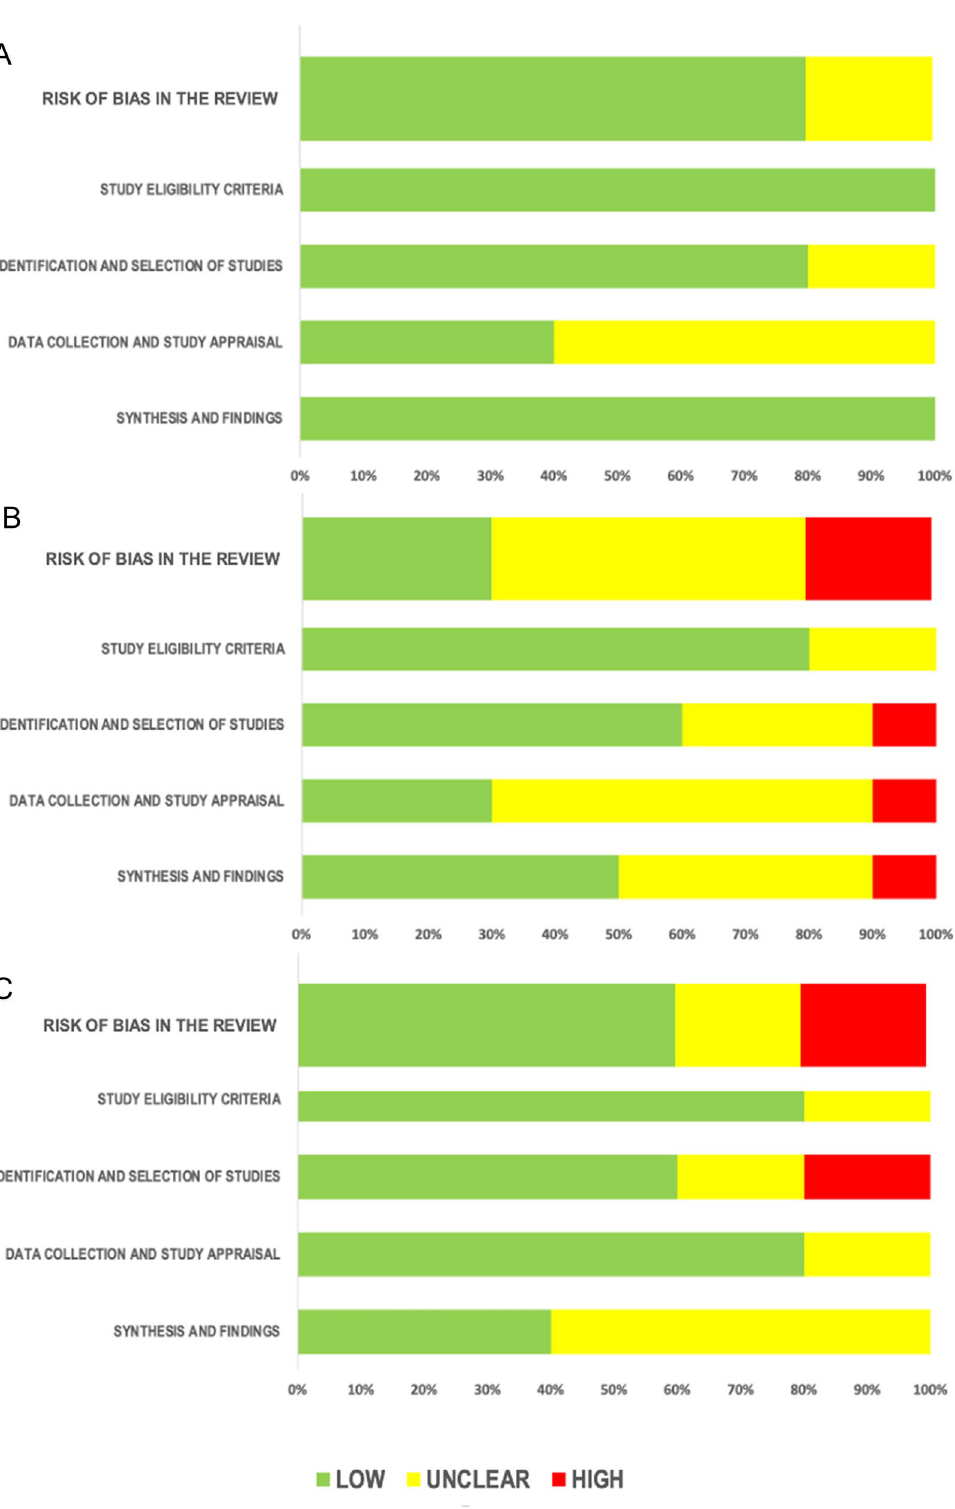
Fig. 1 Results of risk of bias assessment. A , Children and adolescents; B , Peripartum; C , Old age. Phase 2 and 3 of ROBIS are depicted for all the studies included in the umbrella review. Results are presented as percentages of studies at low, unclear or high